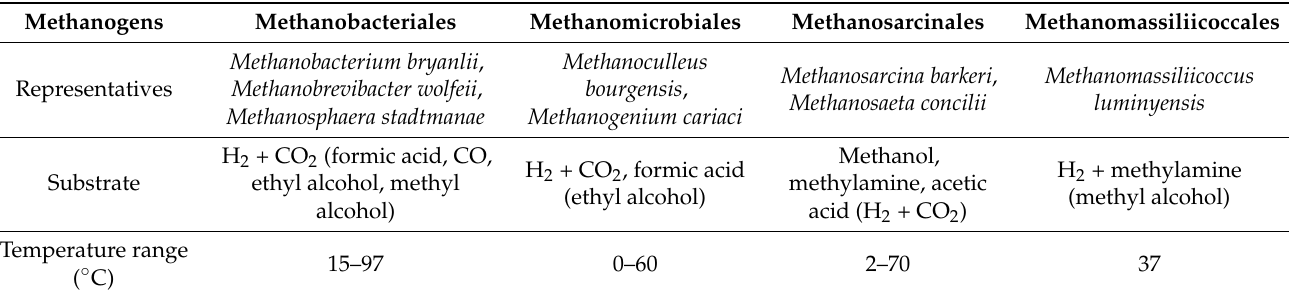
Table 2. Characteristics of the methanogens at order level